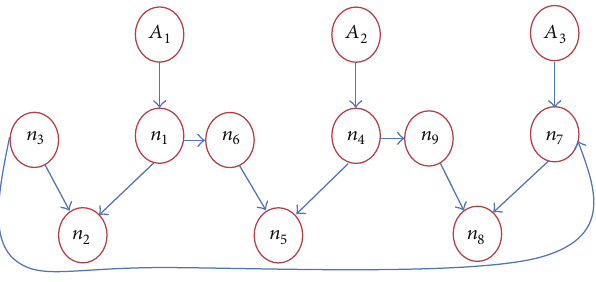
Figure 1: Bayesian